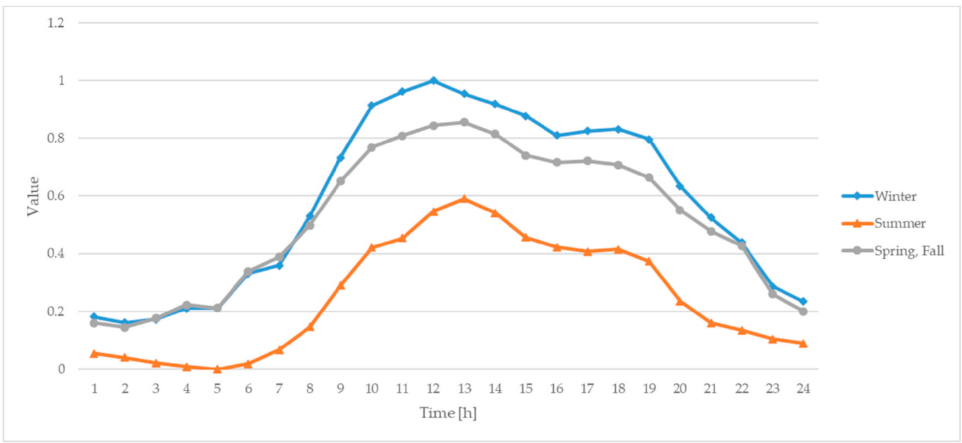
Figure 4. Normalized building load pattern in